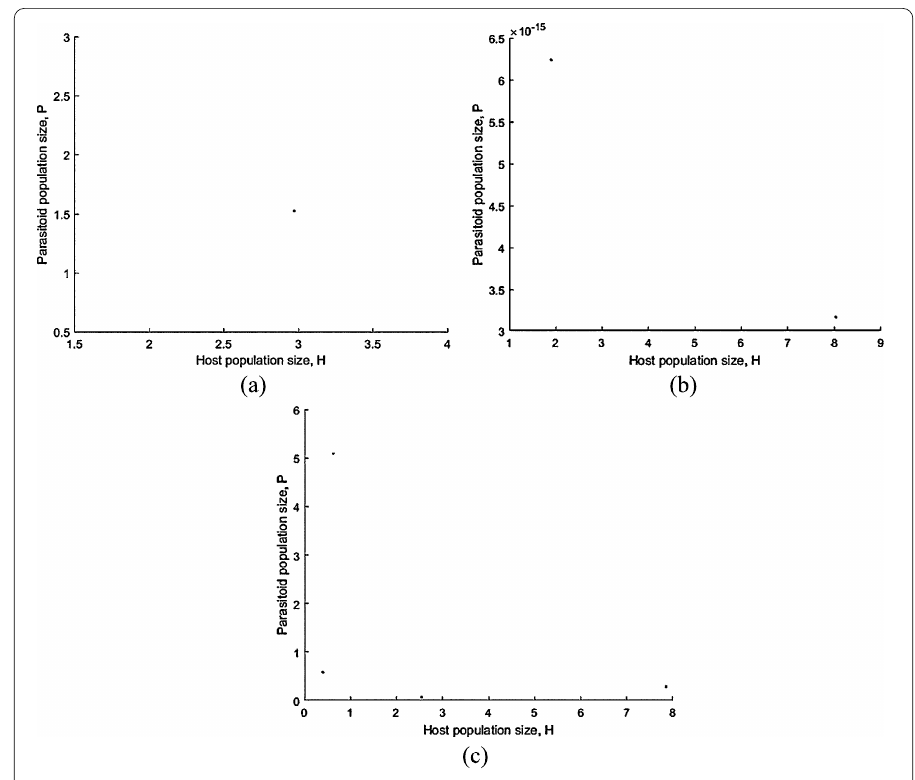
Figure 6 Three alternative attractors (1-cycle, 2-cycle, 4-cycle) for K = 5, n = 0.05, m = 0.01, c = 0.03, b = 0.08, and ( a ) T = 23, T n = 1, r = 1.81; ( b ) T = 23, T n = 10; r = 2.4; ( c ) T = 100, T n = 1, r =